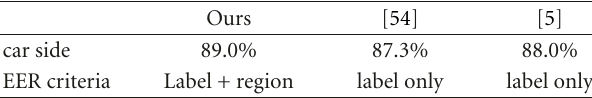
Table 1: Summary of EER performance for car category